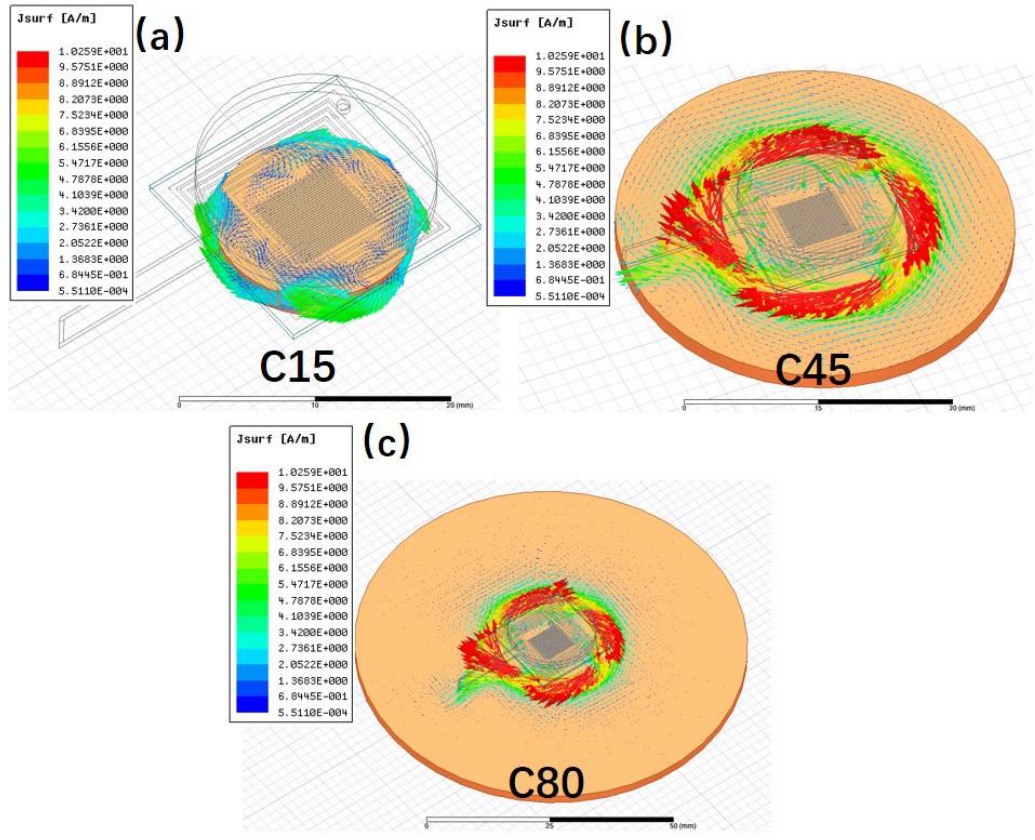
Figure 7. Simulated eddy current distribution for the target of C15, C45, and C80.